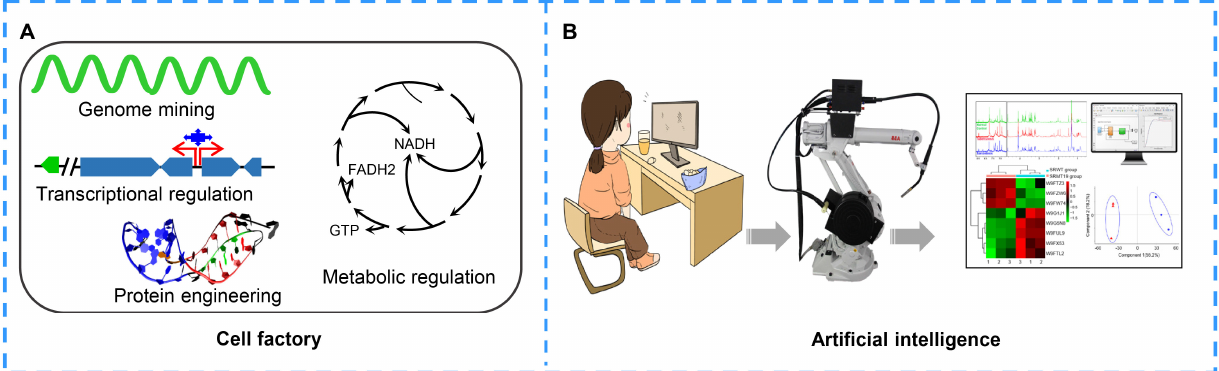
Figure 6. Biosystems for developing natural products. ( A ) Cell factory construction via